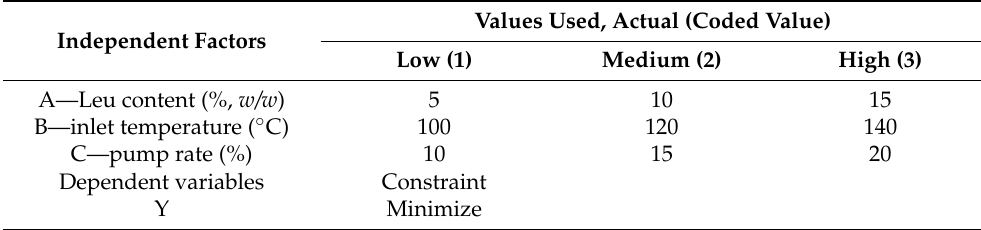
Table 1. Factorial design parameters for optimization of GM spray-dried